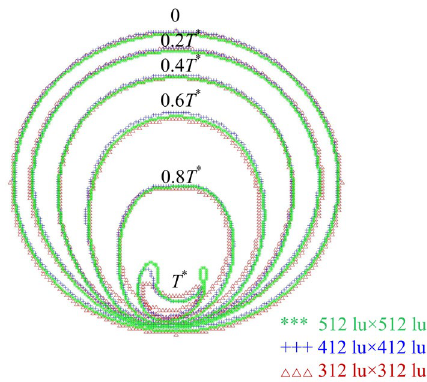
Figure 5. Grid independence verification of the cavitation bubble collapse model near a solid wall with complex geometry.